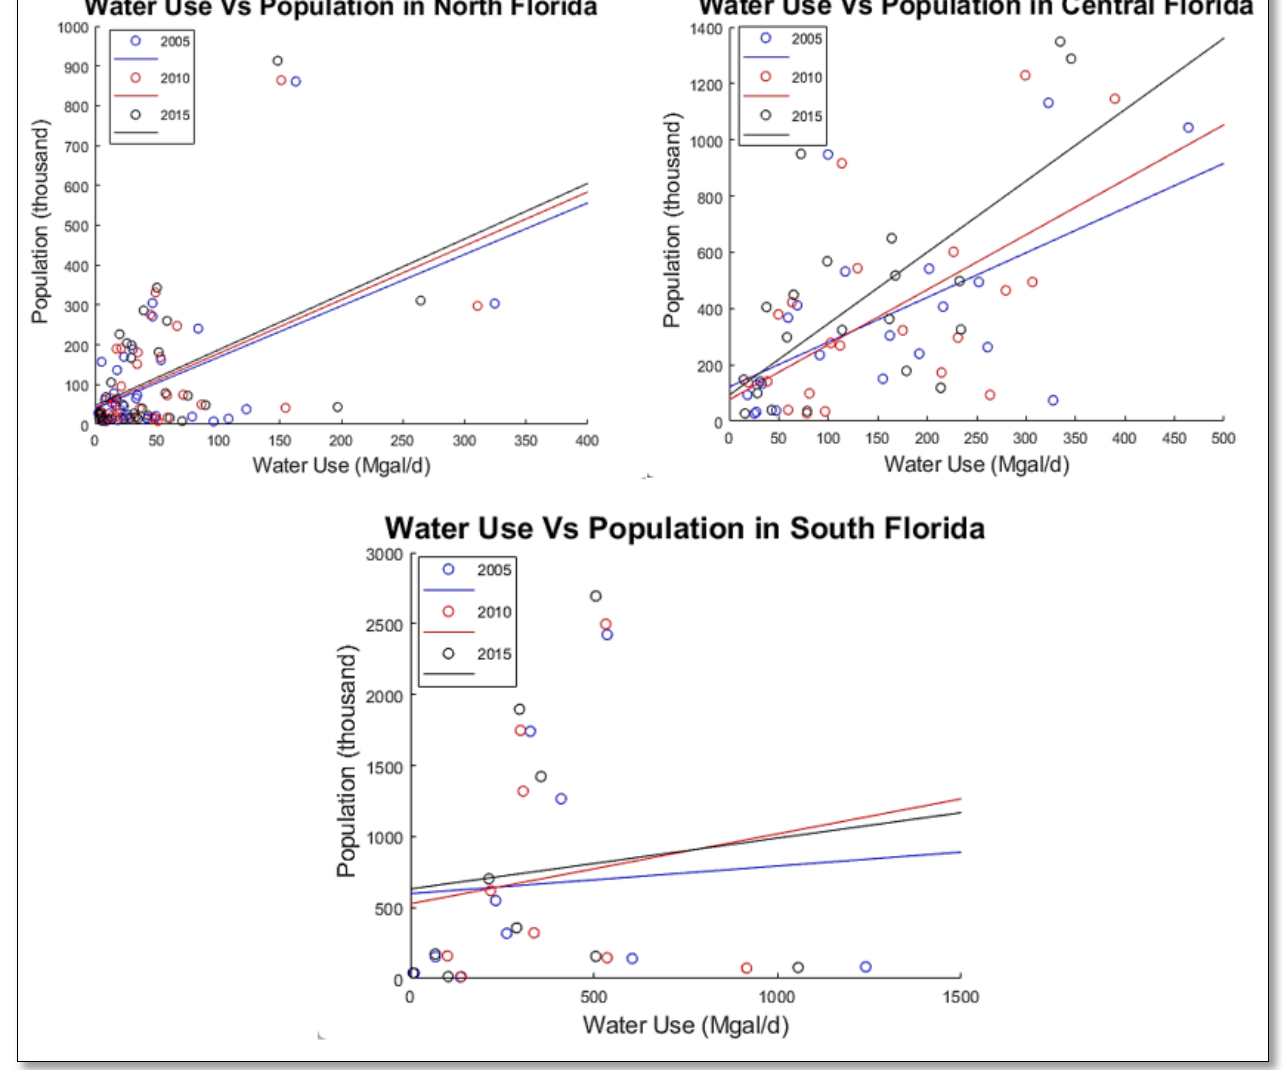
Figure 13. Linear regression analysis of the correlation assessment of public supply and population in north, central, and south Florida. The circles represent the counties in north (36 counties), central (21 counties), and south Florida (10 counties).